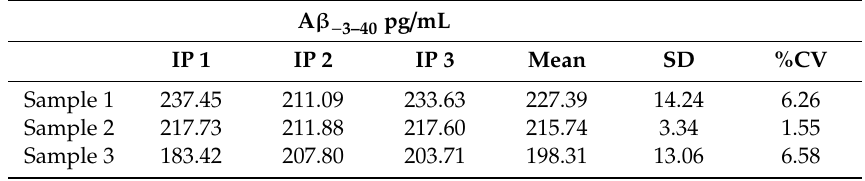
Table 7. Repeatability of manual IPs performed in